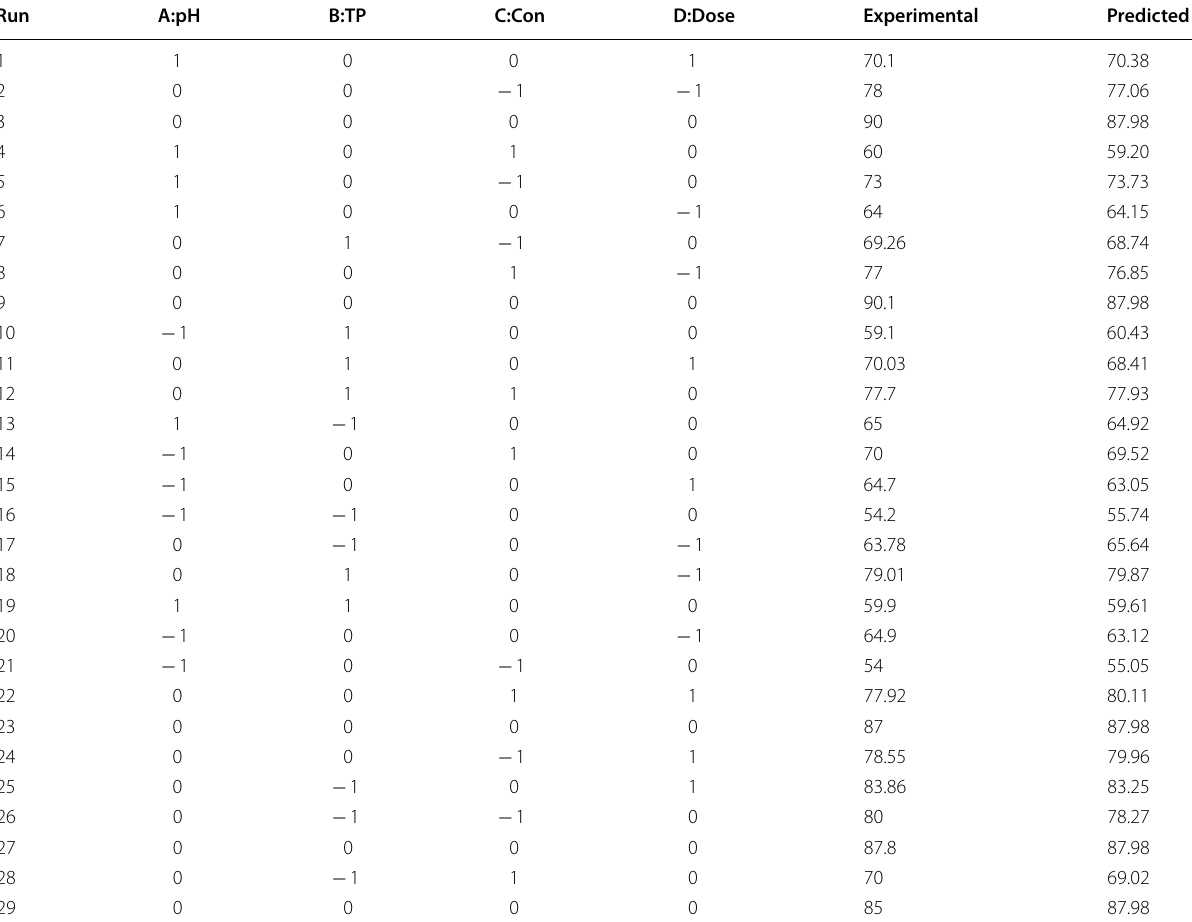
Table 10 Box–Behnken design-based experimental conditions for the decolourization of MG dye by composite Mucor sp.